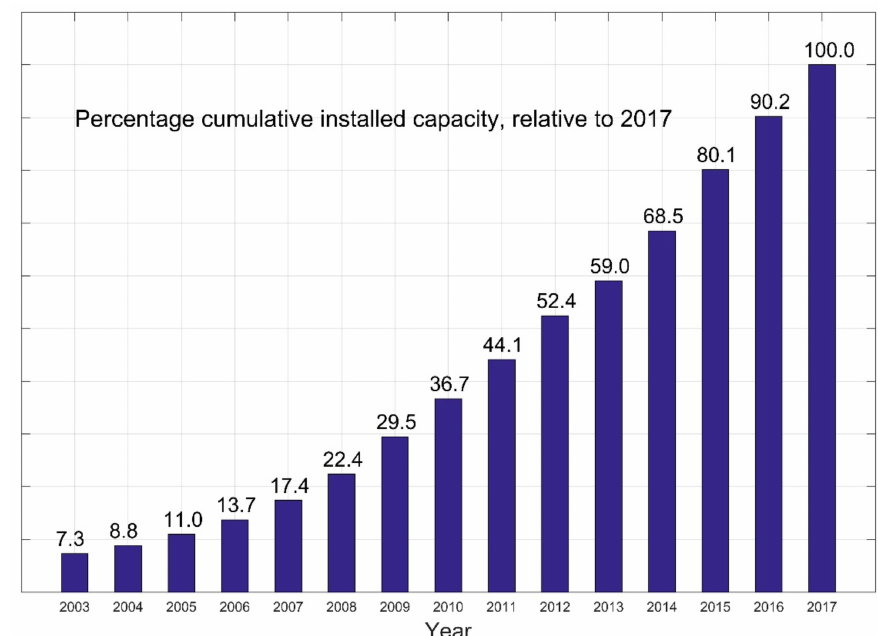
Figure 1. The percentage global cumulative installed wind capacity, relative to 2017, adapted from Reference